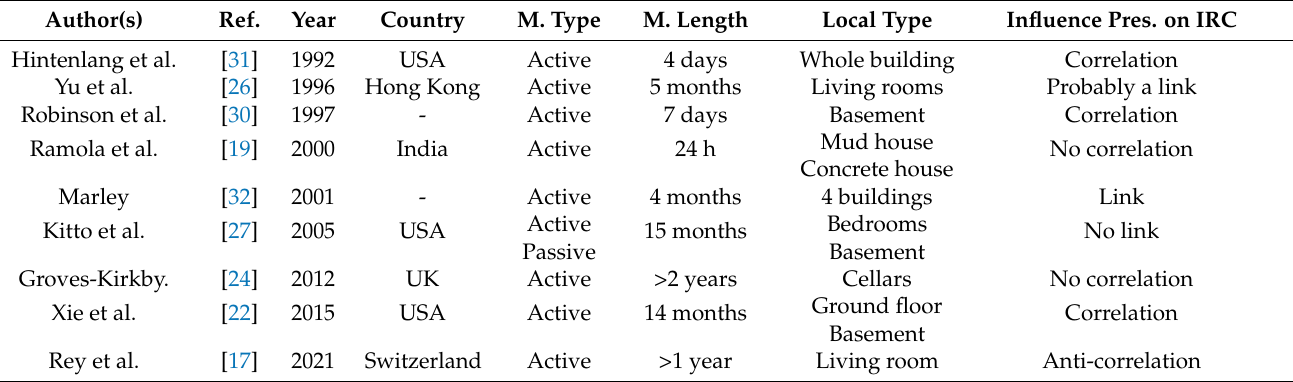
Table 2. Synthesis of atmospheric pressure influences on IRC highlighted in a selected literature. (Ref.: references; M.: measurements; Pres: pressure).